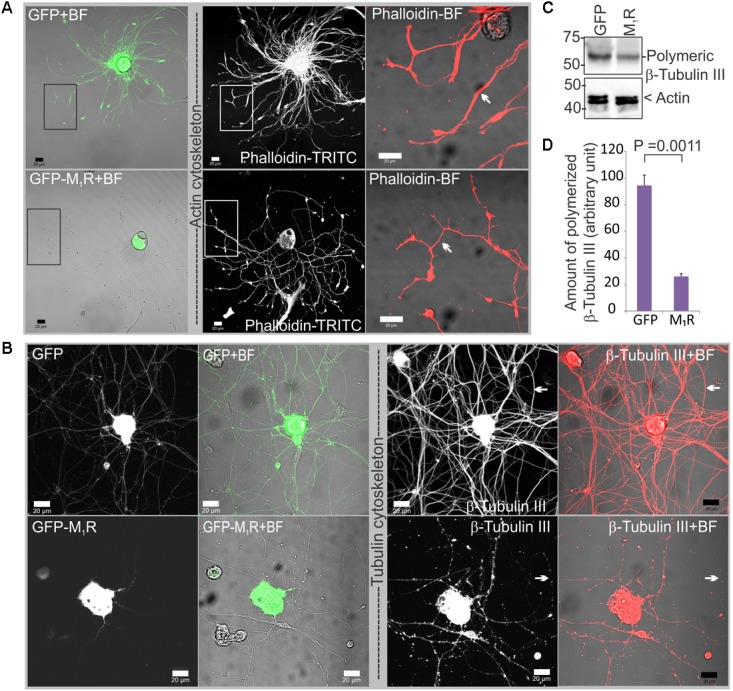
Dorsal root ganglia (DRG) neurons over-expressing M1R exhibited cytoskeletal defects. (A) Actin cytoskeleton in GFP-M1R and GFP over-expressing DRG neurons. White arrow indicates narrower neurites in GFP-M1R expressing neurons. (B) β-tubulin III associated cytoskeleton in GFP-M1R and GFP over-expressing neurons. Black rectangular area is shown in a magnified view in the right panel; white arrow indicates discontinuous/continuous tubulin cytoskeleton. BF, bright field. Scale bar: 20 μm. (C) Immunoblot and (D) bar graph showing relative amount of polymerized tubulin in the M1R-GFP and GFP over-expressed neurons. The data represent the mean ± SEM of three independent experiments. P = 0.0011 calculated by unpaired t-test.